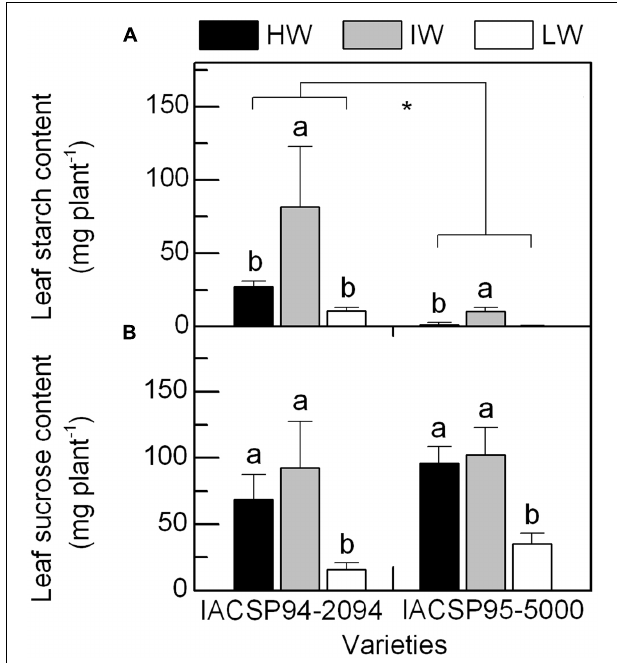
FIGURE 6 | Total content of starch (in A ) and sucrose (in B ) in leaves of sugarcane varieties IACSP94-2094 and IACSP95-5000 exposed to high (HW, black), intermediate (IW, light gray) and low (LW, white) water availability. Each histogram represents the mean ( n = 3) + SD. Lowercase letters compare water regimes for a given variety, while asterisk indicates statistical differences between varieties (Student’s t , p < 0.05).